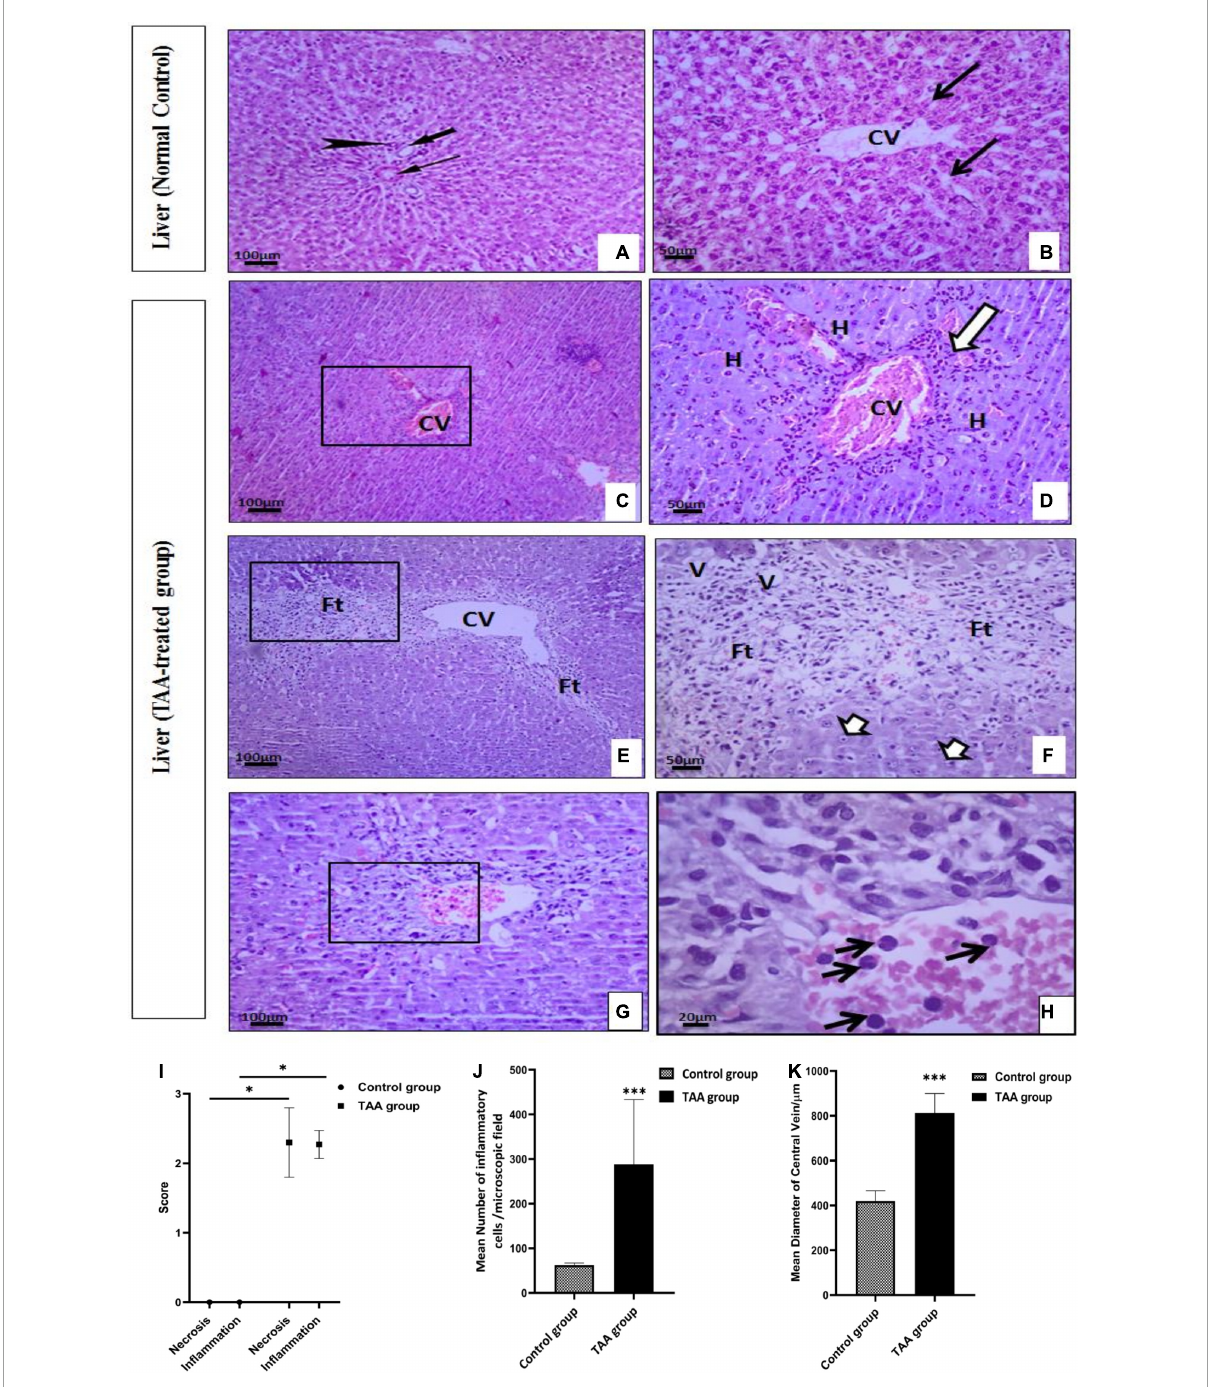
FIGURE2 (A–H) Liver sections of control and TAA-treated groups stained with hematoxylin and eosin: (A,B) Control group. (A) Portal tract with normal portal venule (thin arrow), hepatic arteriole (arrowhead), and bile ductile (thick arrow). (B) Typical liver architecture with hepatic lobule-containing central vein (CV) and radiating hepatocytes cords with blood sinusoids (arrows) in between. (C–H) TAA-treated groups. (C,D) Dilation and congestion of CV (arrowheads) surrounded by inflammatory cell infiltrations (arrow) and hydropic degeneration of hepatocytes (H) . (E,F) Dilated CV is surrounded by massive fibrous tissue proliferation (Ft) associated with vacuolar degeneration (V) and nuclear pyknosis (short arrows). (G,H) Necrotic centrilobular area (rectangle) with inflammatory cell infiltration (arrow). X100 bar 100, X 400 bar 50 and X: 1,000 bar 20. (I) The graph represents hepatocyte necrosis and the extent of inflammatory cell infiltration. Data are expressed as mean ± SD. ∗ p < 0.01 vs. control group. (J) The mean number of inflammatory cells/microscopic field. Data are displayed as mean ± SD. ∗∗∗ p < 0.001 vs. control group. (K) The mean diameter of the ventral vein ( µ m). Data are displayed as mean ± SD. ∗∗∗ p < 0.001 vs. control